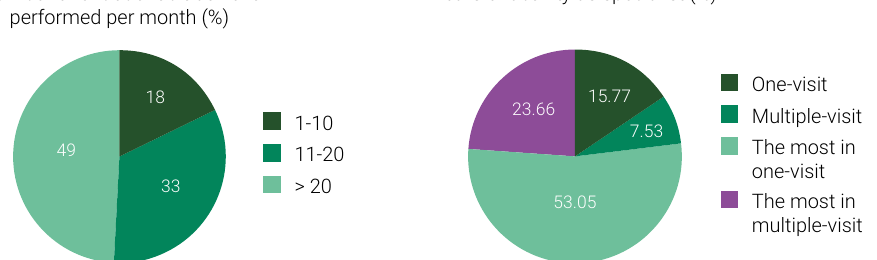
Number of endodontic tratment performed per month